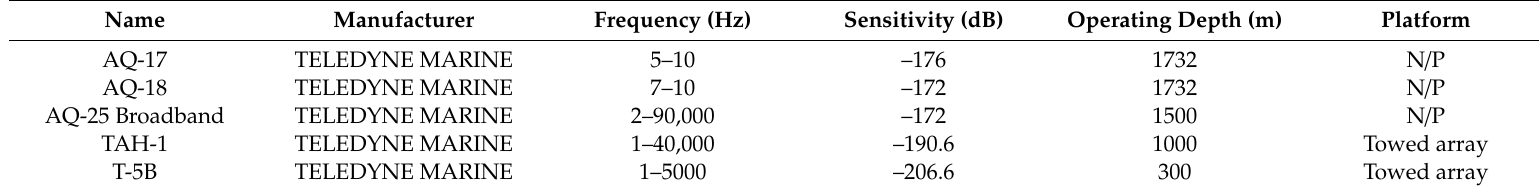
Table 15. Acoustic sensor: passive—hydrophones.